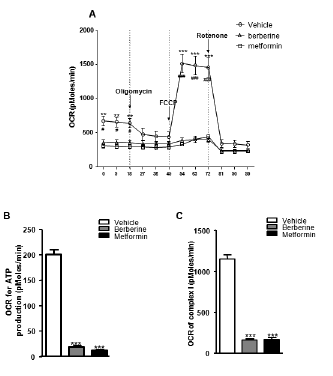
Figure 1. Effects of berberine on ATP synthesis and complex I - linked respiration in C2C12 myotubes. Cells were treated with berberine (20 m mol/L) or metformin (5 mmol/L) for 24 h, followed by XF bioenergetic assay. A: Traces of OCRs in control, berberine- or metformin-treated C2C12 cells followed the addition of oligomycin, FCCP and rotenone. Results are shown as means 6 SEM, n= 3. # P , 0.05, ###